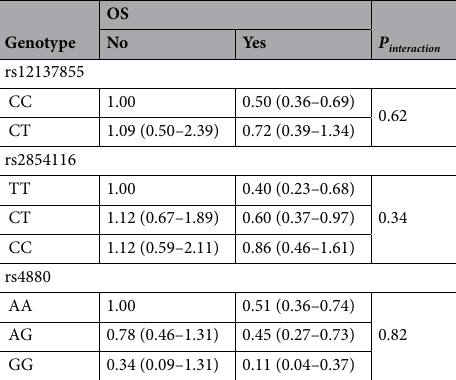
Table 6. Analysis of the cross- classification interaction of OS-gene. Adjusted variables included: Smoking status, drinking status, DASH diet score, physical activity level, sleep quality, BMI, hypertension, HUA, and shift work